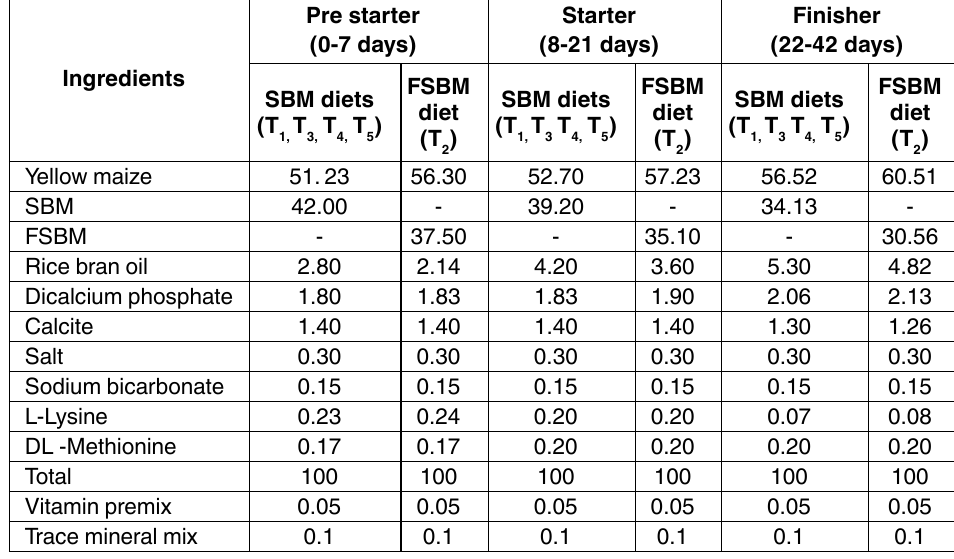
Table 2. Ingredient composition of experimental rations, per cent